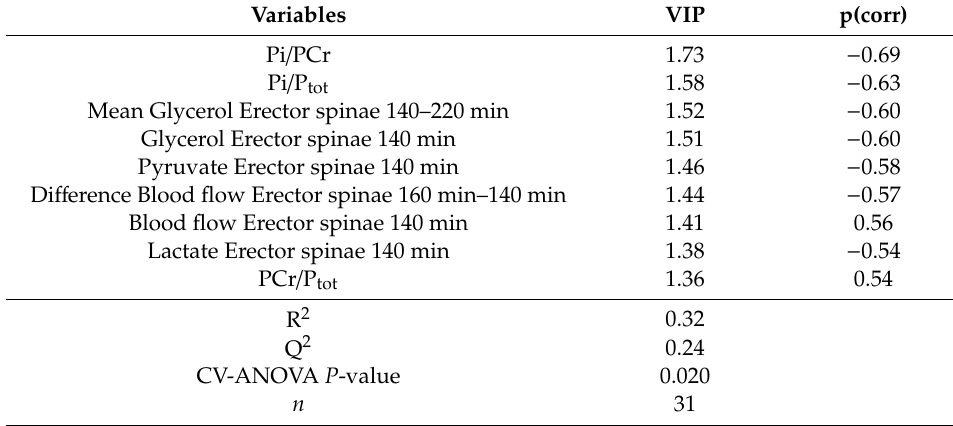
Table 8. OPLS of PPT over erector spinae in FM. Regressors used data from microdialysis and spectroscopy of this muscle (except pain variables from microdialysis) (cf. Tables 3 and 4). The regression had one predictive component. Only significant variables are shown (i.e., variables with VIP > 1.0 and absolute p(corr) ≥